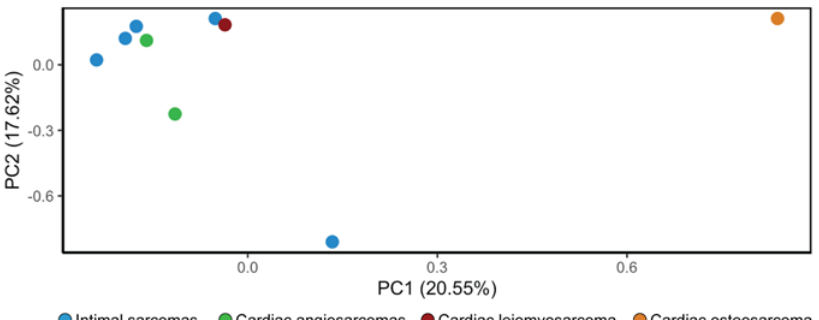
Figure 3. Unsupervised principal component analysis (PCA) performed on intimal sarcomas (n = 5), cardiac angiosarcomas (n = 2), leiomyosarcoma (n = 1), and osteosarcoma (n = 1). The osteosarcoma case (orange dot) is separated from the other samples along the first principal component, proving to have a distinct gene signature.